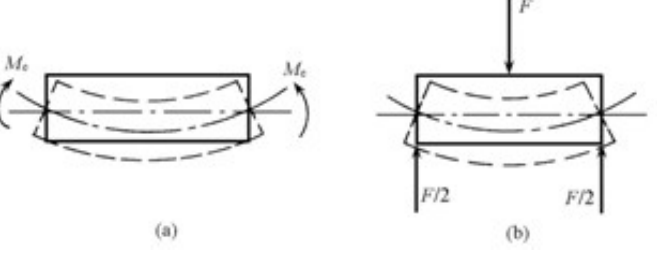
Fig. 8 Bending deformation of